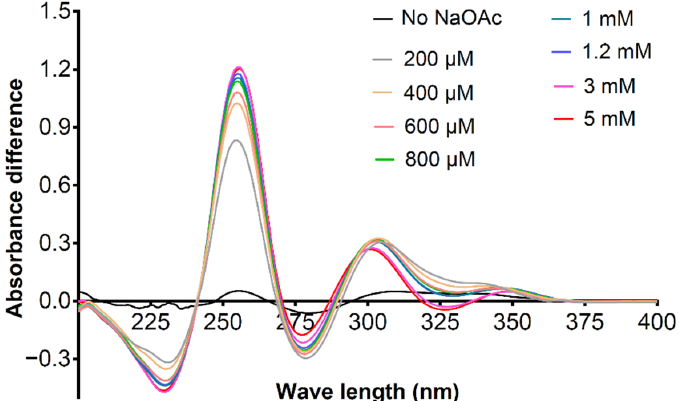
Figure 6. The differential ultraviolet-visible (UV-Vis) spectra caused by the addition of 80 μ M MgCl 2 in the presence of 0–5 mm NaOAc. The differential spectra were obtained by subtracting the absorbance of the control group (50 μ M 21e , 0–5 mm NaOAc) from that of the sample group (50 μ M 21e , the same concentration of NaOAc as in the control group, 80 μ M MgCl 2 ) at the corresponding wavelength (200–400 nm). Methanol was used as the solvent.